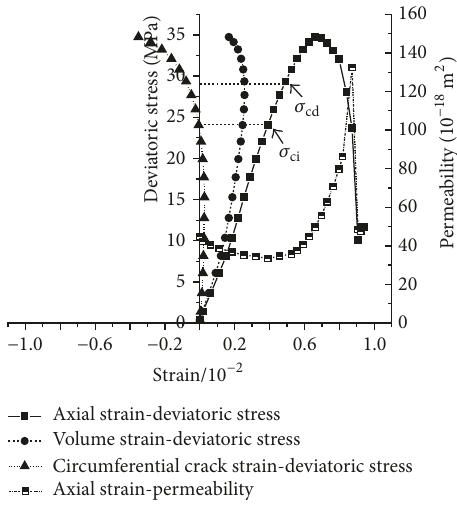
(b) Sandstone with mud (water pressure 3MPa + confin- ing pressure 6MPa)